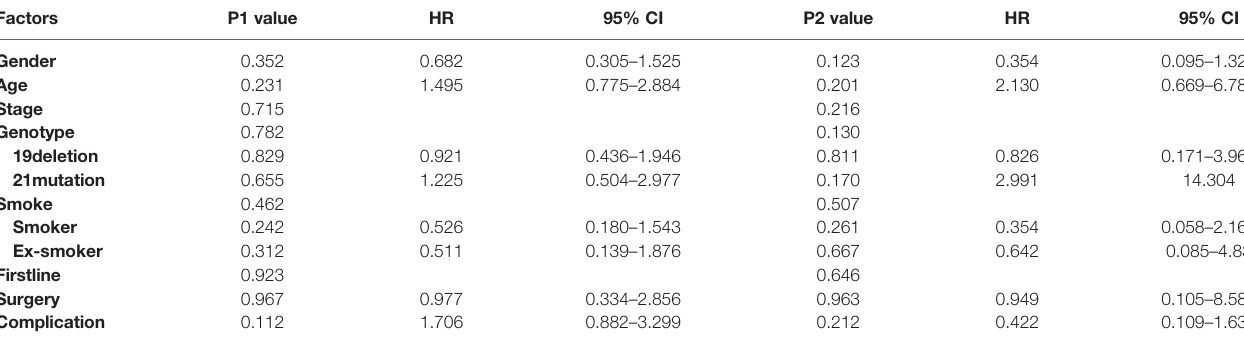
TABLE 2 | The association between overall survival and progression free survival was calculated by Cox regression models. Factors P1 value HR 95% CI P2 value Gender